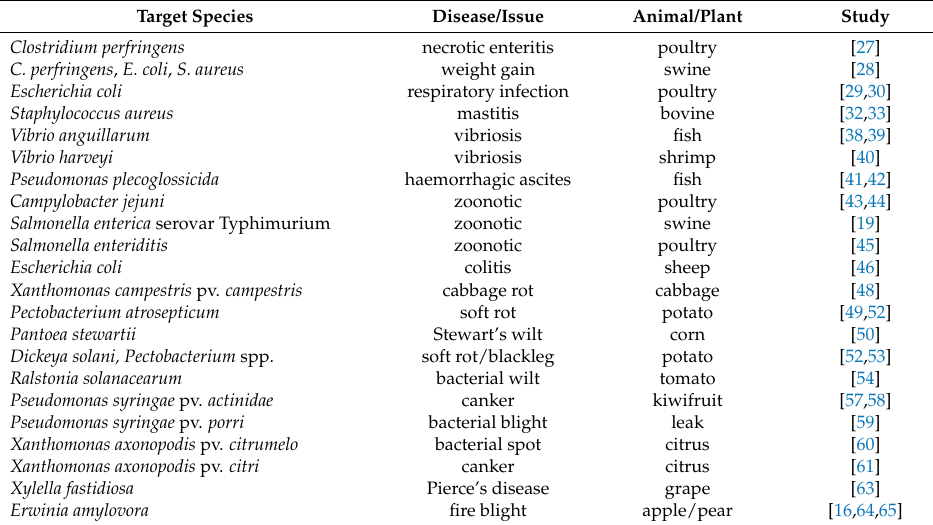
Table 1. Experimental studies using bacteriophages to control bacterial